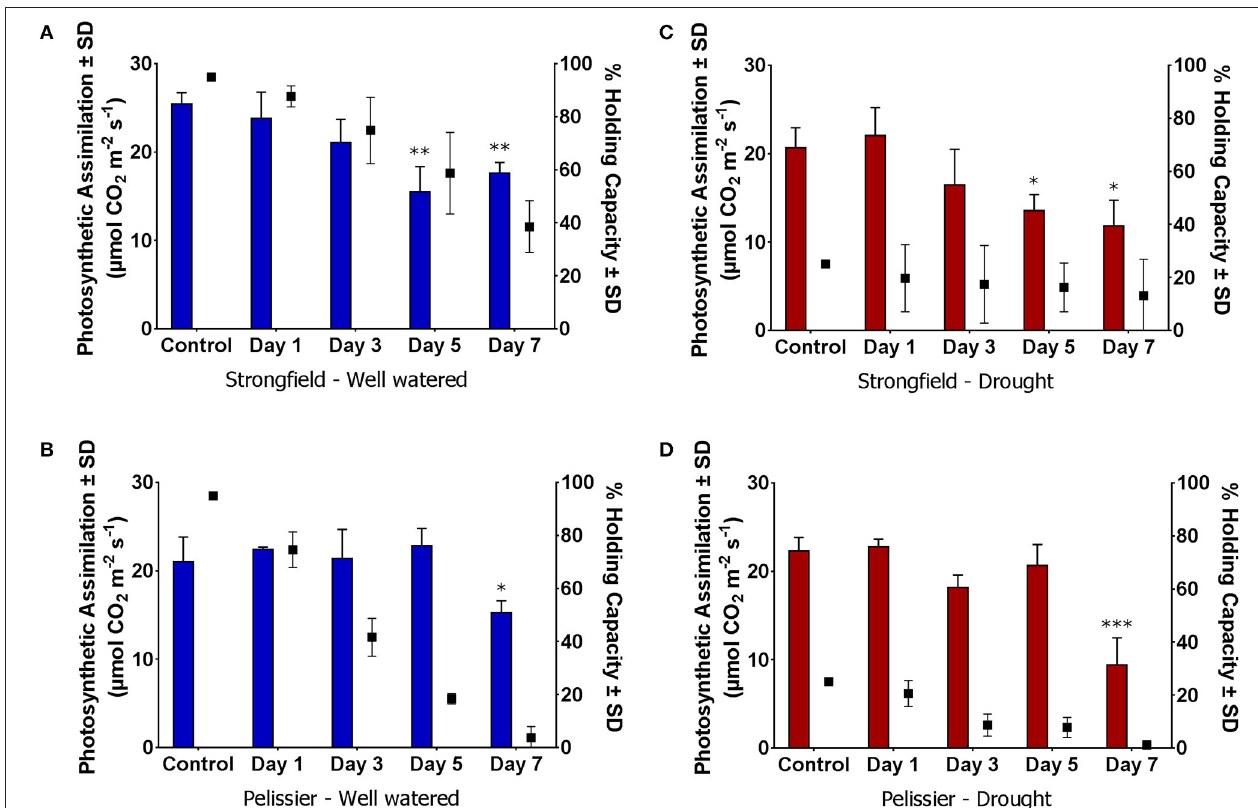
FIGURE 6 | Reduction in photosynthetic CO 2 assimilation upon gradual moisture loss from initially water replete and droughted conditions. (A,C) Initial water holding capacity at 95%; (B,D) Initial water holding capacity 25%; “Control” refers to measurements taken within 2–4h of watering on Day 0. Day 1 through 7, no watering. Water availability data is summarized in Table 1 and depicted here for ease of visualization of changes in photosynthesis with reductions in available water. Water holding capacity shown on right y-axis ( • symbol). One-way ANOVA followed by Dunnett’s multiple comparisons test was performed for each variety under each water status treatment (* p < 0.05, ** p < 0.01, *** p <